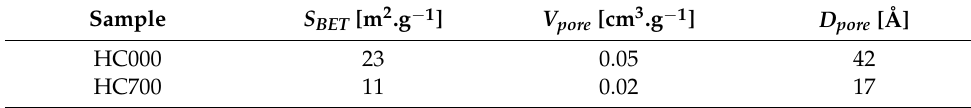
Table 3. BET surface and textural characteristics of